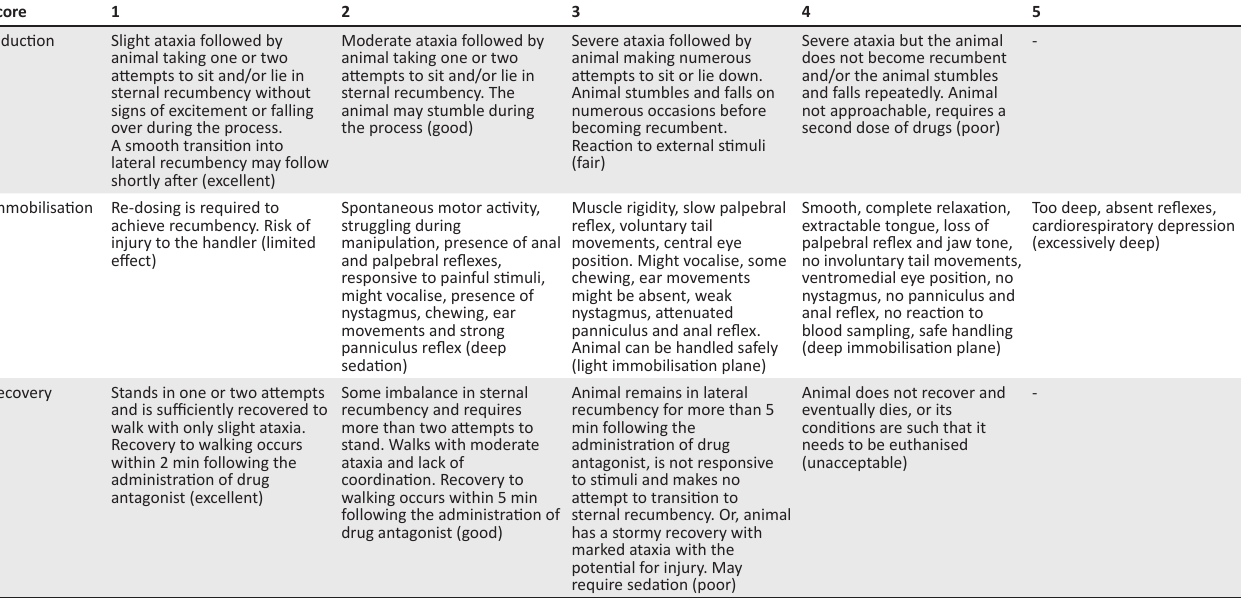
TABLE 1: Description of the scoring system used to categorise the quality of induction, immobilisation and recovery of blesbok immobilised with two etorphine–azaperone combinations. †